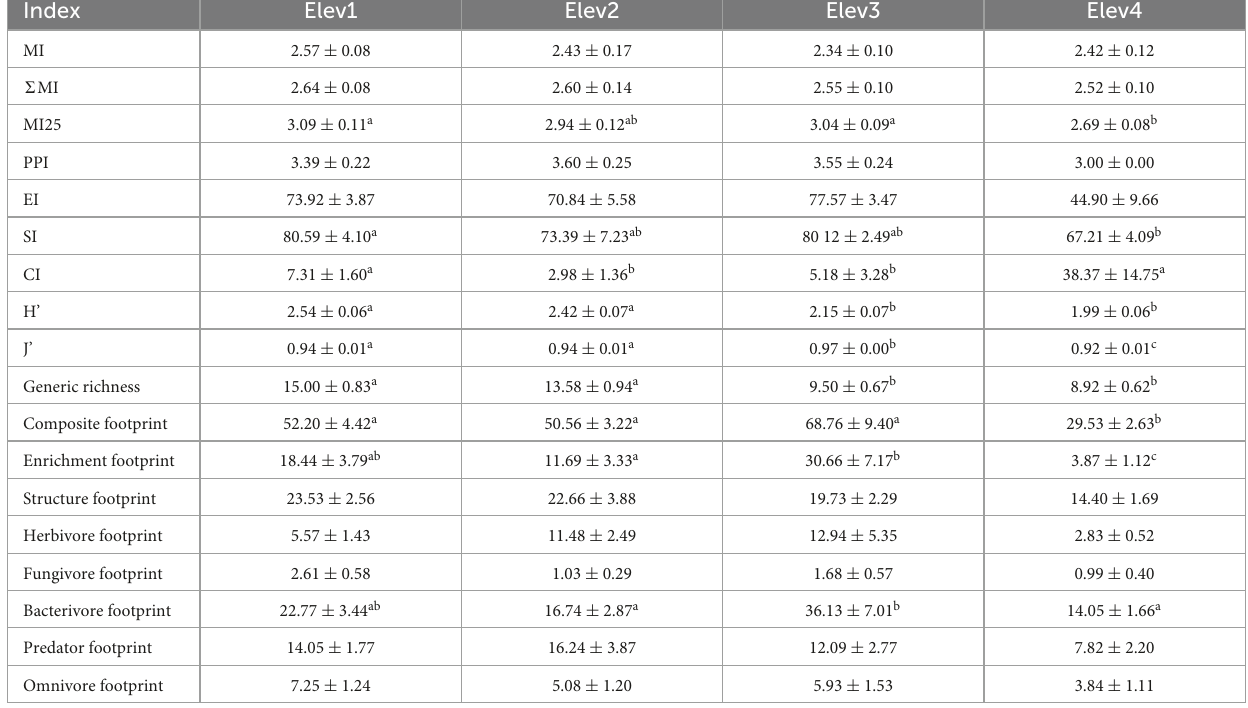
TABLE 5 Soil nematode functional diversity and metabolic indices across the studied elevation classes (mean ± standard